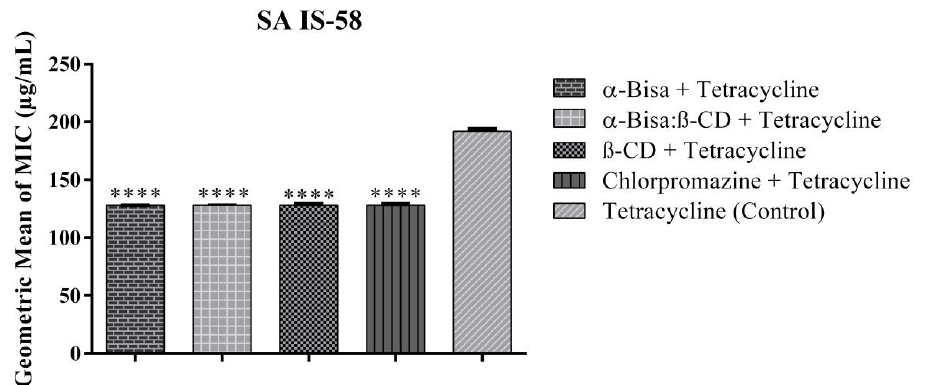
Figure 1. E ff ect of the compounds associated with tetracycline against Staphylococcus aureus